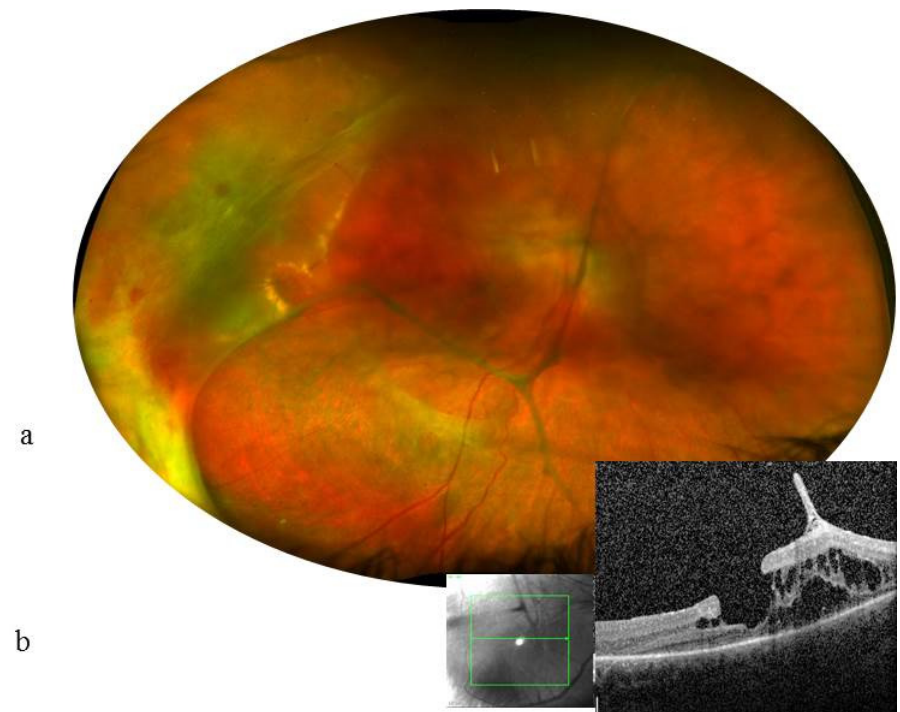
Figure 3. Case 5. 13-year-old girl. VA at 1.6/10 (0.8 LogMAR) in the RE and no light perception in the LE. RE: ( a ): Color fundus photograph shows many thick condensations of the posterior hyaloid and a detachment of the temporal retina. ( b ) horizontal scan (green lines) OCT showed intraretinal cysts, vitreoretinal traction, and a lamellar hole in the RE (magnification ×20). Cysts are mainly located within the internal nuclear layer and the external retinal layers; the external nuclear, external limiting, and ellipsoid layers have disappeared at 1000 µm from the center.